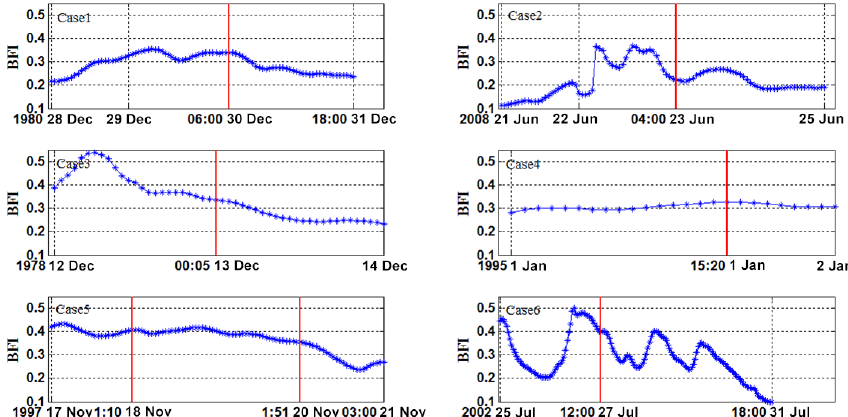
Figure 4. Time series of simulated BFIs (cases 1–6), red lines refer to the freak waves occurrence